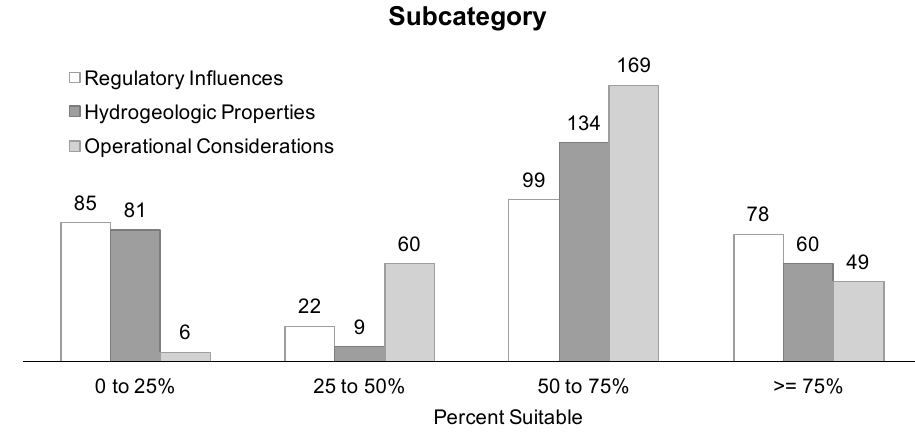
Figure 8. Site Scoring Scheme subcategory results.